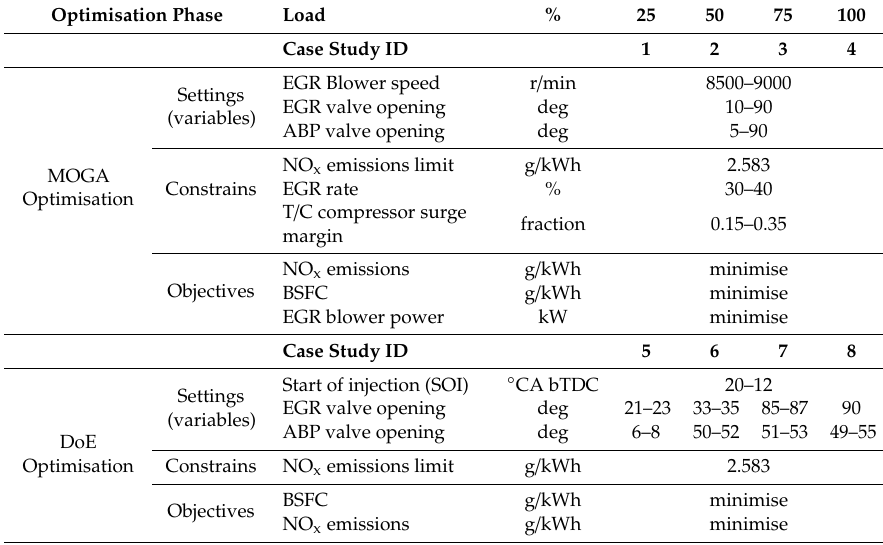
Table 4. Optimisation process